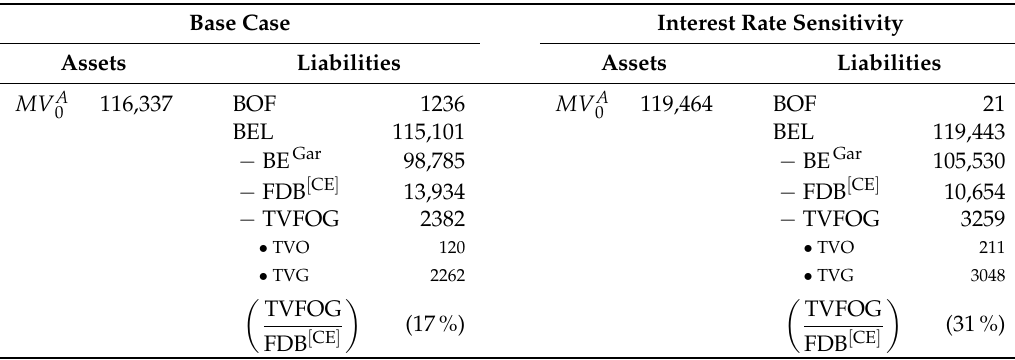
Table 7. Economic balance sheet at time t = 0 (in A